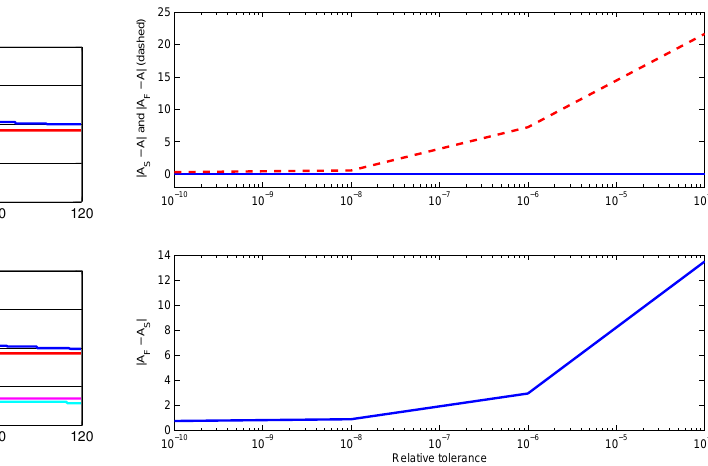
Figure 7: Level controller setpoints (MVs, top) and level and valve openings (CVs, bottom) in inlet separator. Red line is oil, blue line is water, magenta is oil valve opening, cyan is water valve opening.